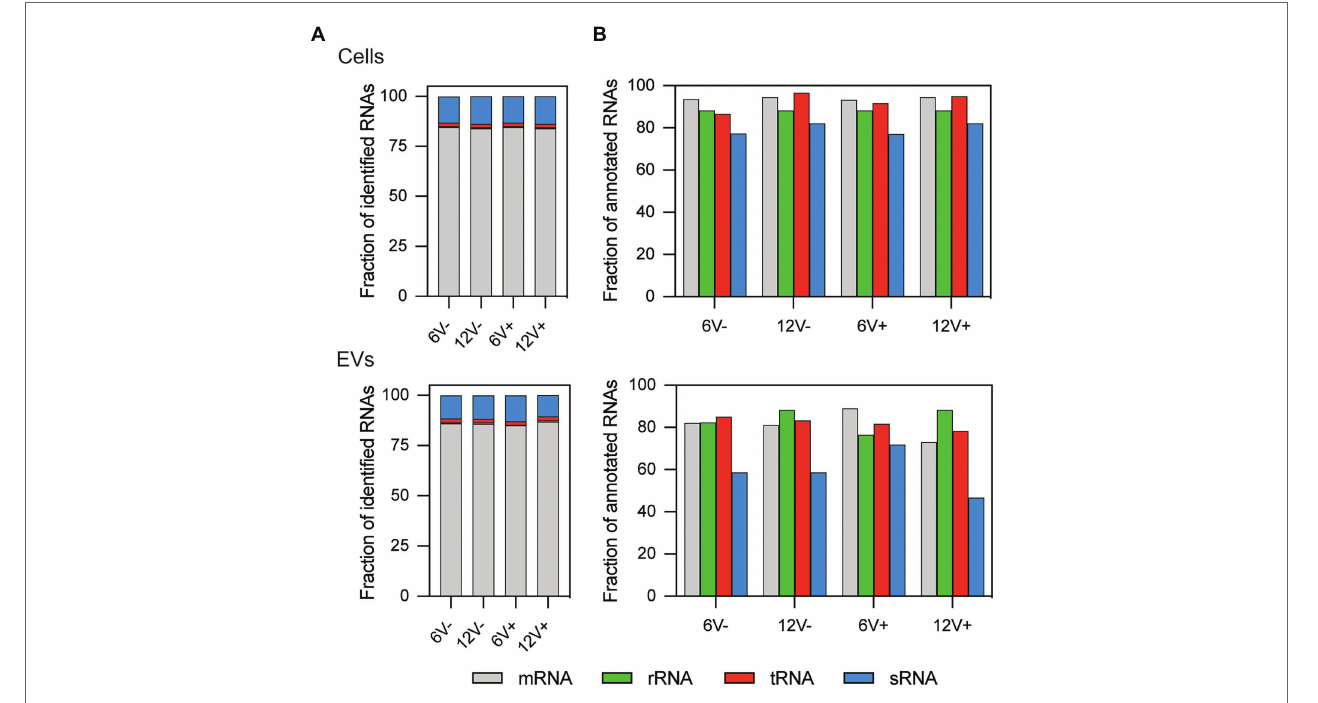
FIGURE 2 | Relative RNA composition of S. aureus HG003 and its secreted EVs. Individual colored bars represent the relative amount of each RNA class for mapped reads (A) and annotated RNAs (B) . RNA-Seq data is the average of three independent replicates. Number of reads have been normalized with EdgeR. RNA classes are defined from the S. aureus genome annotation NCTC8325/HG003. Early- and late-stationary growth phases (6 and 12, respectively) in absence (V − ) or presence (V+) of vancomycin.